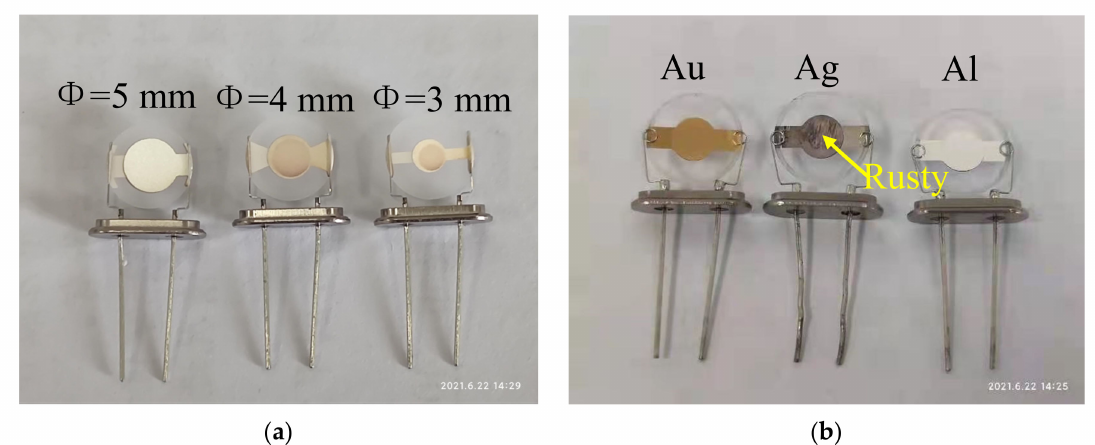
Figure 4. QCM resonator devices with different electrode diameters or materials: ( a ) QCM resonator devices with different electrode diameters; ( b ) QCM resonator devices with different electrode